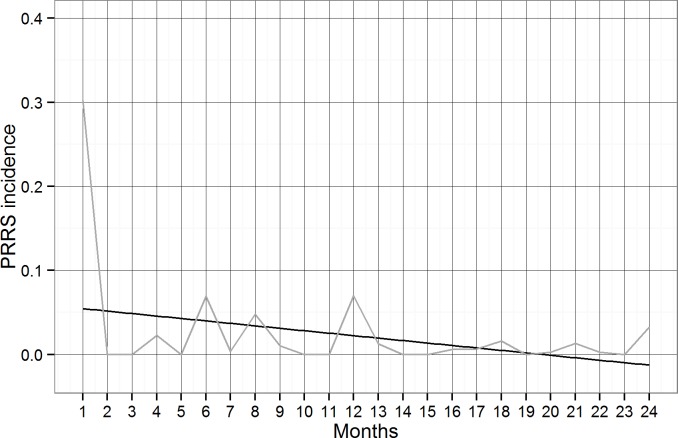
Observed PRRS incidence (grey line) and estimated linear trend (black line) of PRRS incidence between July 2012 and June 2014 in in the RCP- N212.Months from July 2012 to June 2014 are represented from 1 to 24.